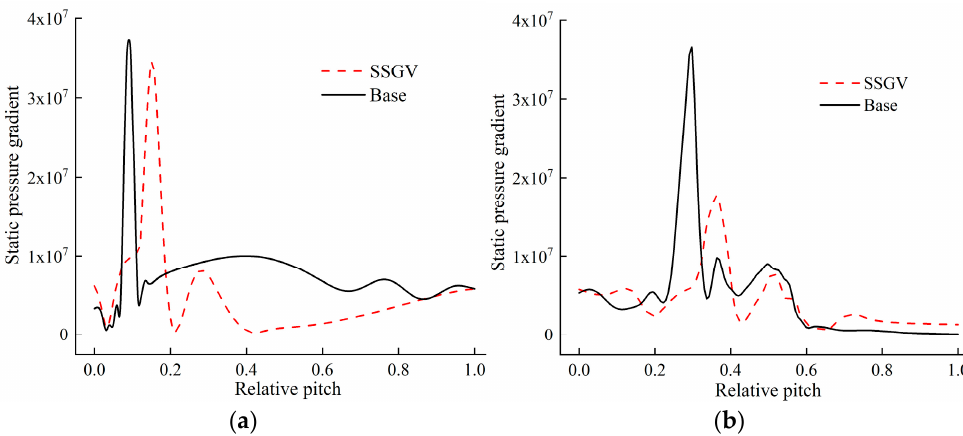
Figure 12. Shock distribution at the guide vane trailing edge and rotor leading edge of the two models: ( a ) shock distribution at the guide vane trailing edge; ( b ) shock distribution at the rotor leading edge.